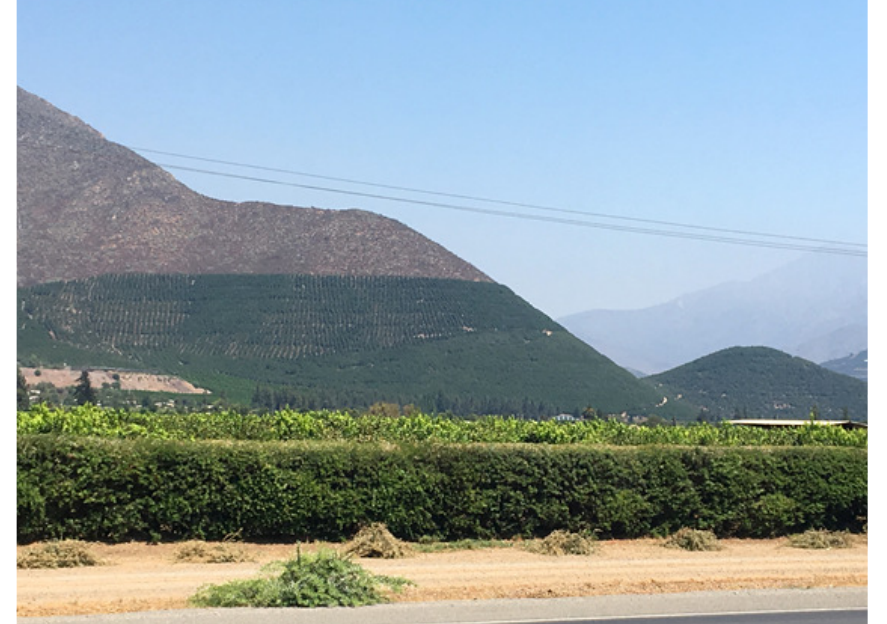
Figure 10. Fruit plantations in the Central Valley, Region of Valparaíso, Chile. Source: Courtesy of Francisco Báez (photo‐ graph taken circa 2019).